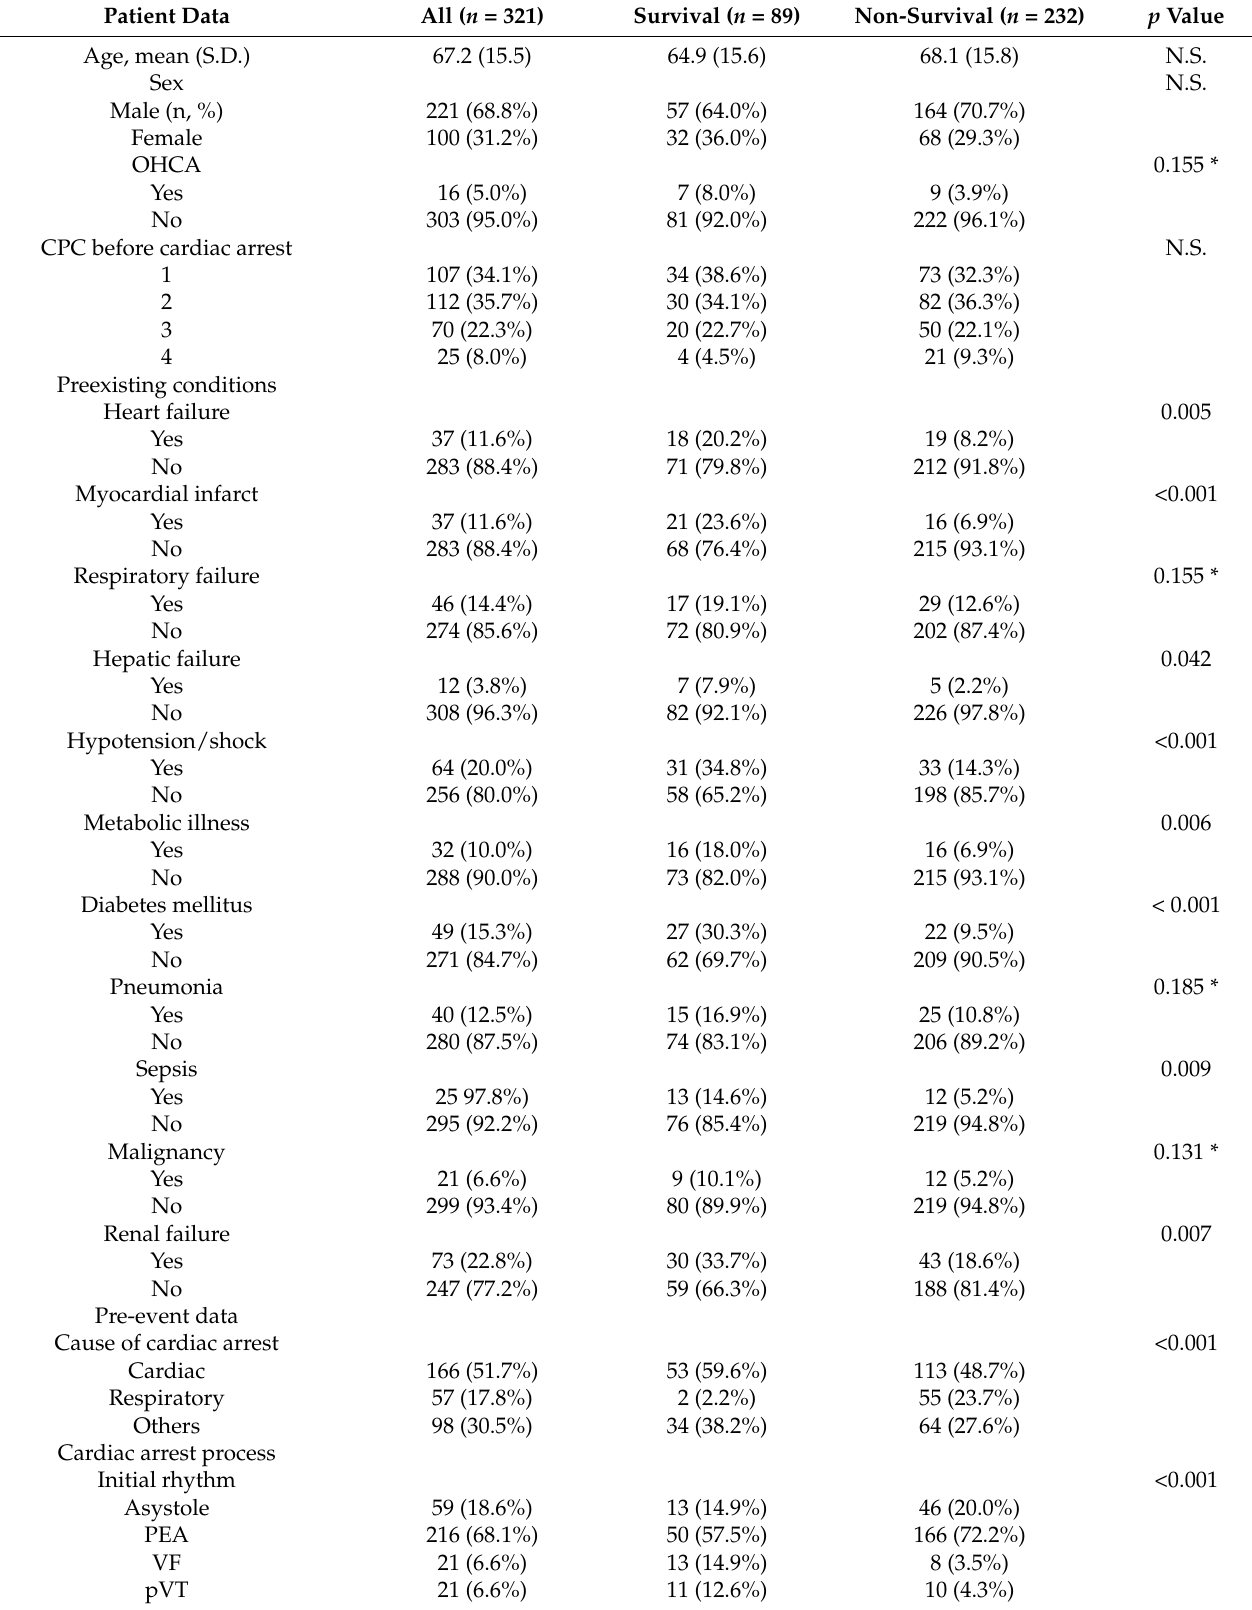
Table 1. Clinical characteristics and Utstein style elements of survival and non-survival IHCA